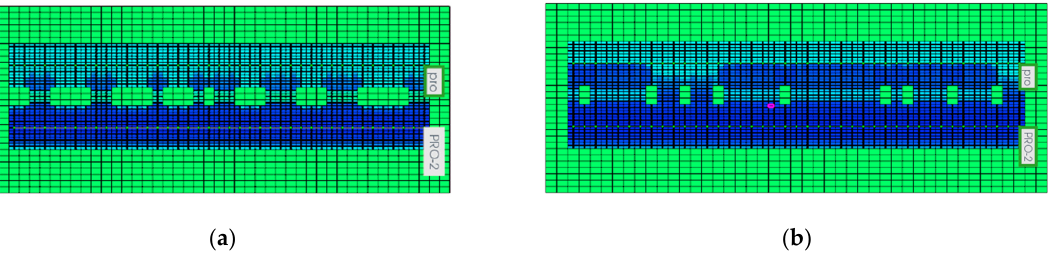
Figure 8. Comparison of gas rate and water rate of different scenarios. ( a ) Gas rate. ( b ) Water rate.